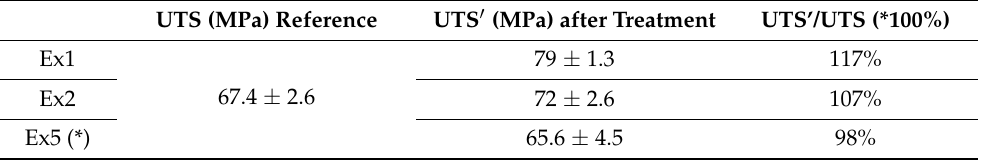
Table 3. The mean UTS before (UTS) and after (UTS ′ ) treatment.